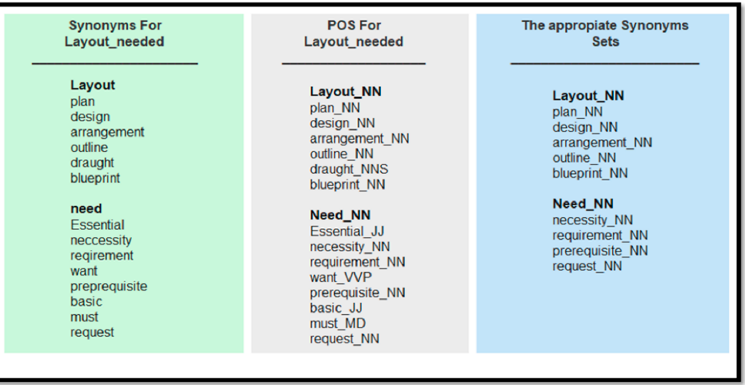
Figure 8. The reduction process of synonyms sets using POS.